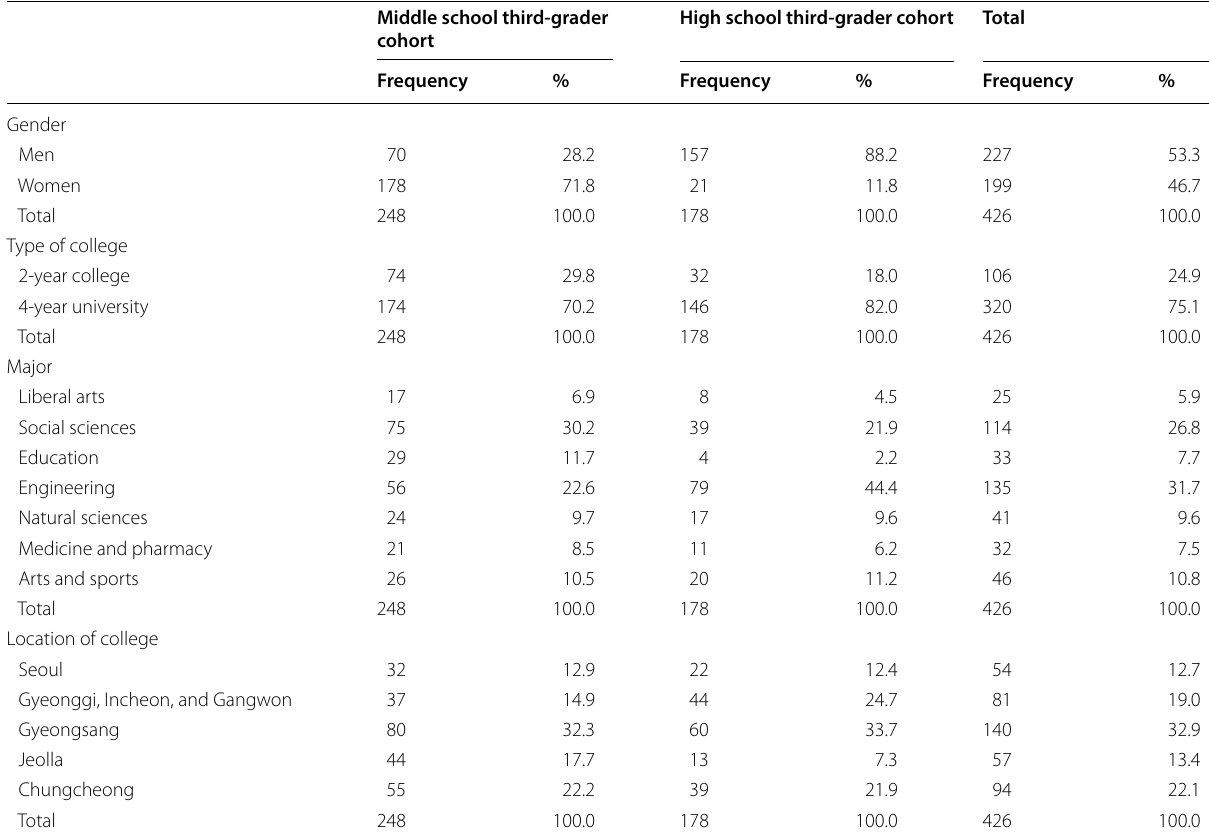
Table 3 General characteristics of the subjects